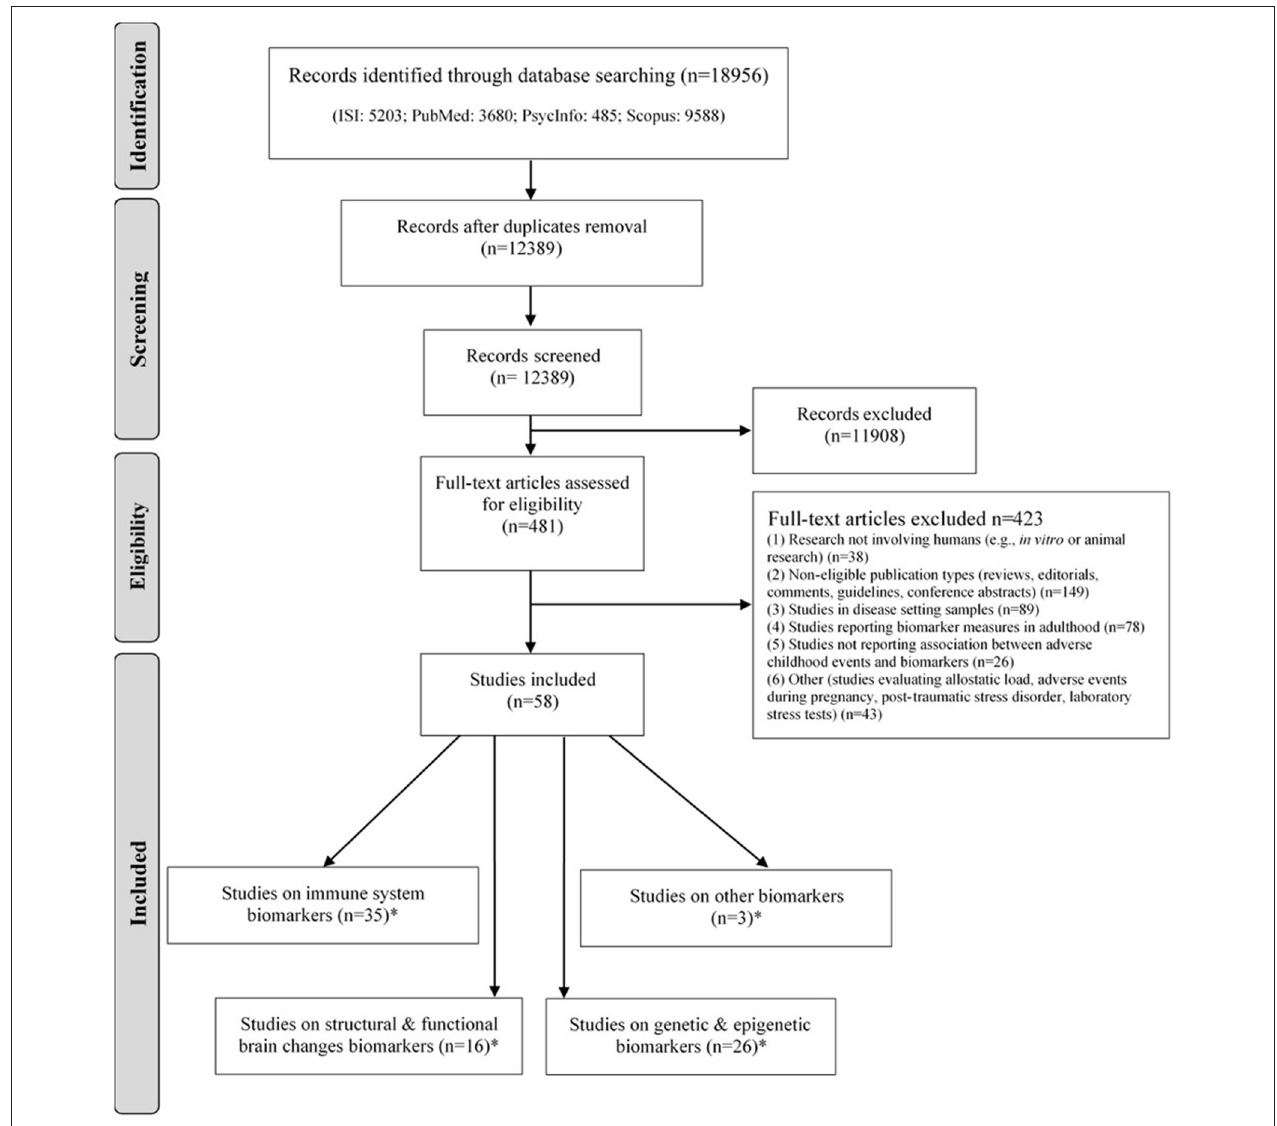
FIGURE 1 | PRISMA flow diagram of the literature